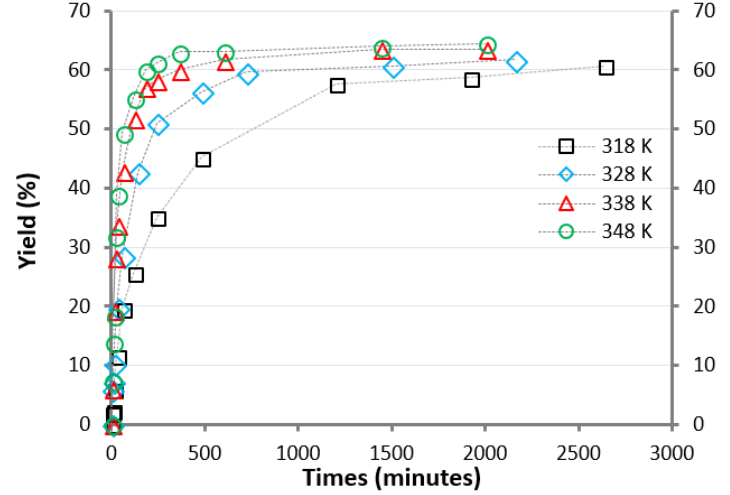
Figure 1. Direct esterification of Levulinic Acid (LA) with ethanol evaluated at different times and temperatures. Yields of ethyl levulinate (EL) were plotted vs. time. Reaction conditions: molar ratio ethanol:LA:AlCl 3 ·6H 2 O = 1:1:0.01, temperatures from 318 to 348 K, time = 40 h.